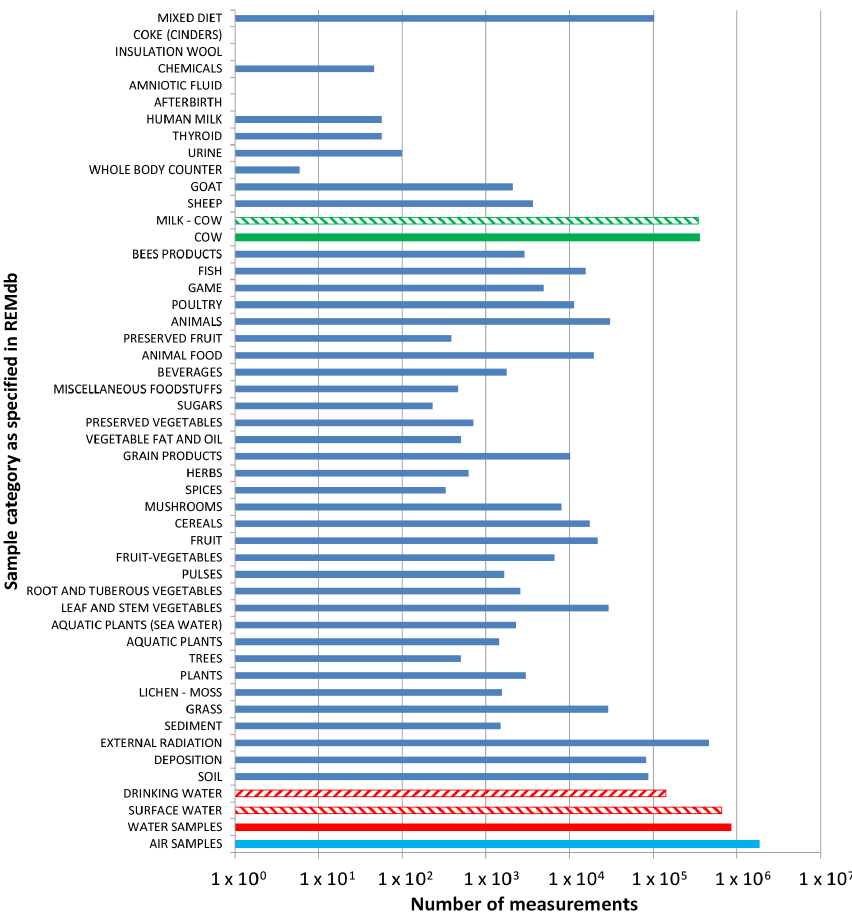
Figure 4. Number of measurements per sample type as specified in REMdb (logarithmic scale, subtypes surface water and drinking water are included in type water samples, subtype milk-cow is included in type cow).